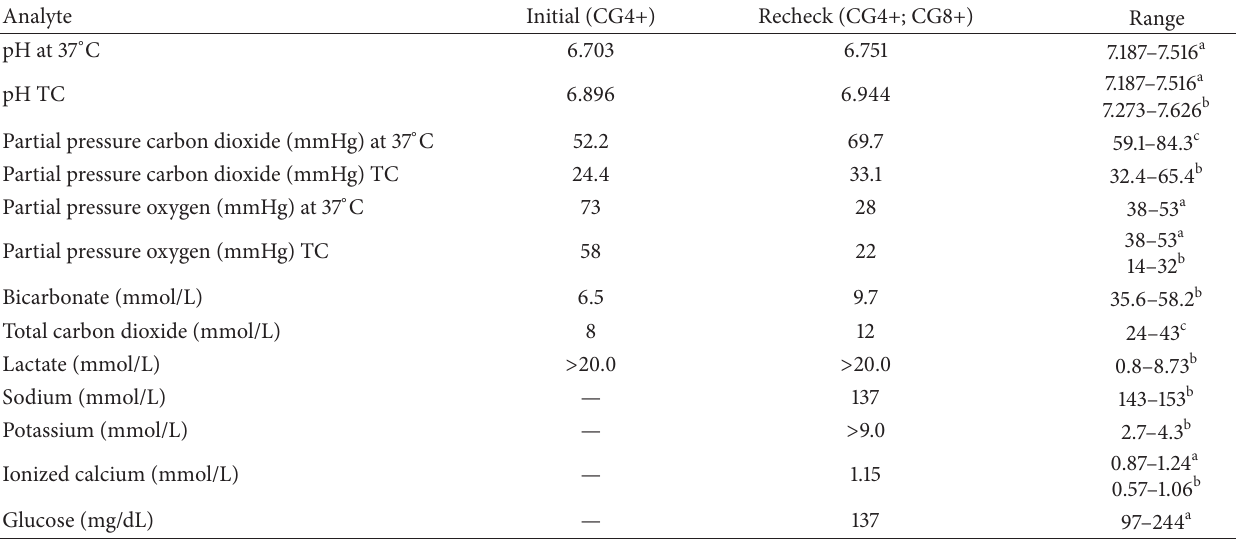
Table 1: Blood gas results from a large mesh gillnet entangled green sea turtle ( Chelonia mydas ). Values marked with “—” were not obtained. Initial sample was obtained at presentation and the recheck sample was performed approximately 4 hours later. Blood gas analysis performed using iSTAT CG4+ and CG8+ cartridges. Range values based on published iSTAT results of free-ranging juvenile green sea turtles [18, 19]. Temperature correction (TC) was performed at the turtle’s cloacal temperature (20.0 ∘ C) for pH, pCO 2 , pO 2 , and ionized calcium based on formulas presented in Anderson et al. 2011 [18].